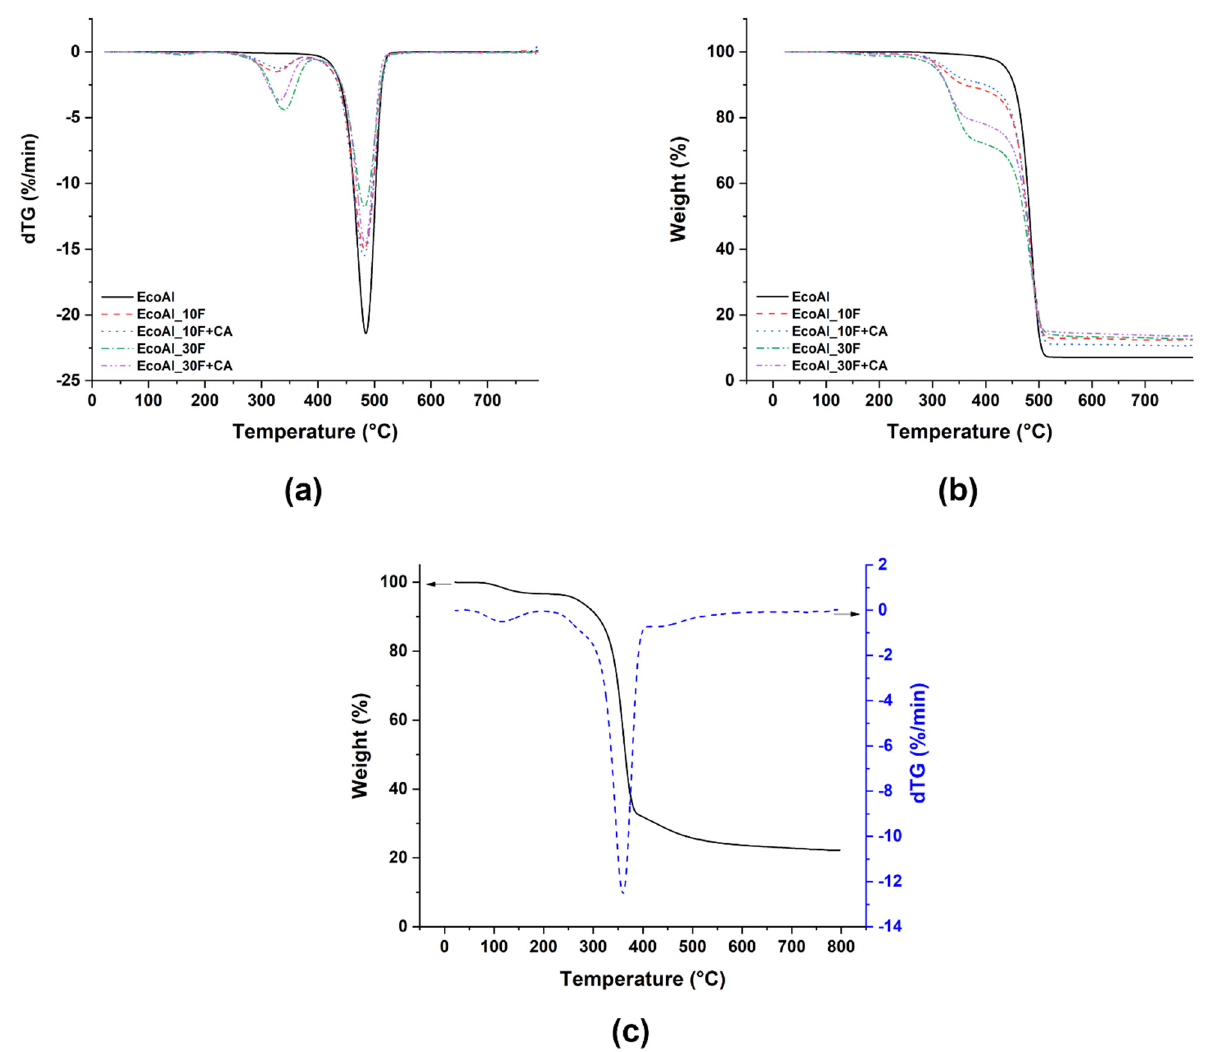
Figure 1. ( a ) Derivative (dTG) and ( b ) TG curves for all EcoAllene-based formulations along with ( c ) neat flax fibres.